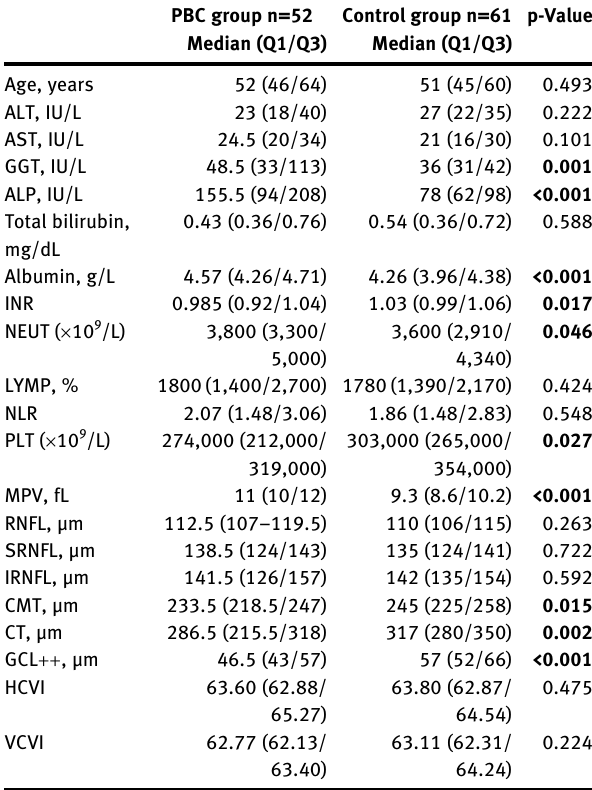
Table  : Age, optic coherens tomography and biochemical param- eters in PBC and control